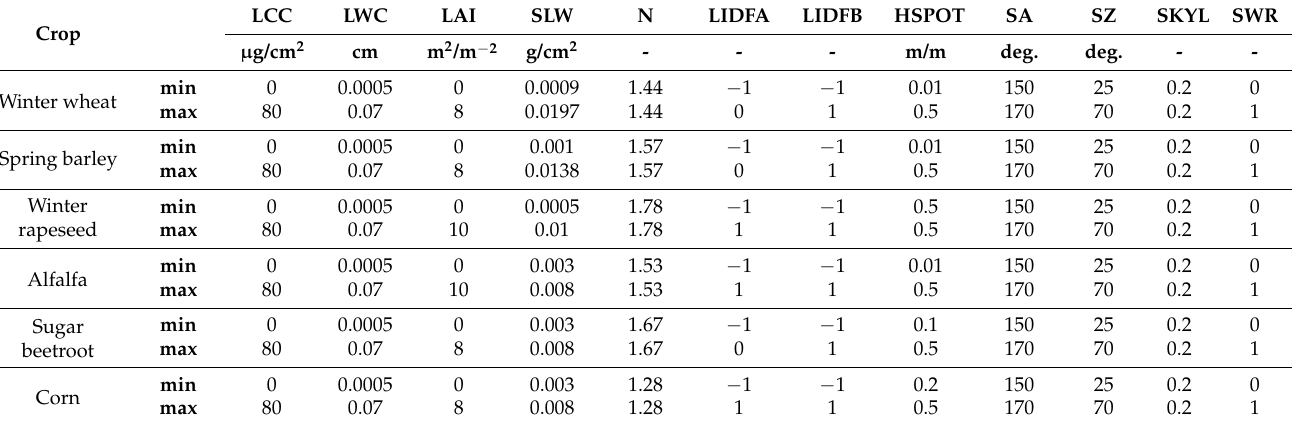
Table A1. Ranges of the PROSAIL model inputs used for the generation of look-up tables (LCC = leaf chlorophyll content, LWC = leaf water content; LAI = leaf area index; SLW = specific leaf weight; SA, SZ = solar azimuth and zenith angles; SKYL = fraction of diffuse solar radiation; SWR = soil wetness ratio. N, LIDFa, LIDFb, and HSpot are leaf and canopy structural